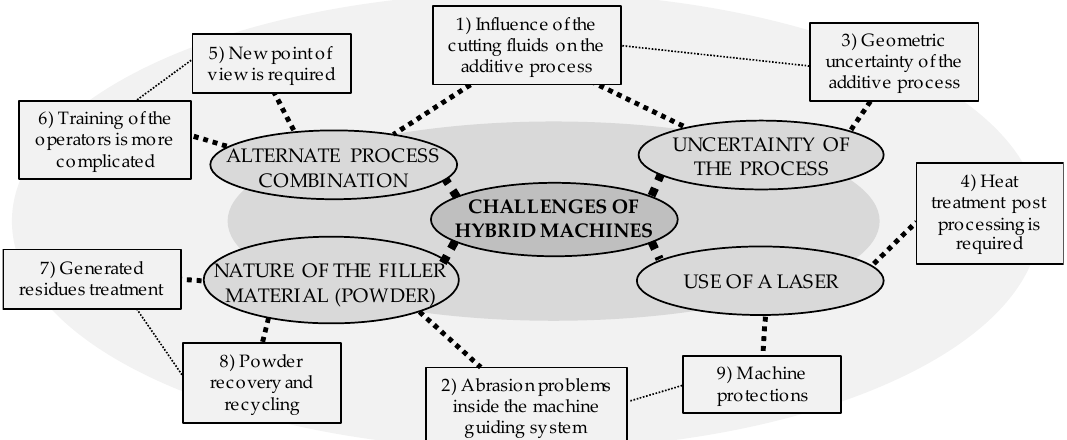
Figure 7. Challenges of hybrid machines.